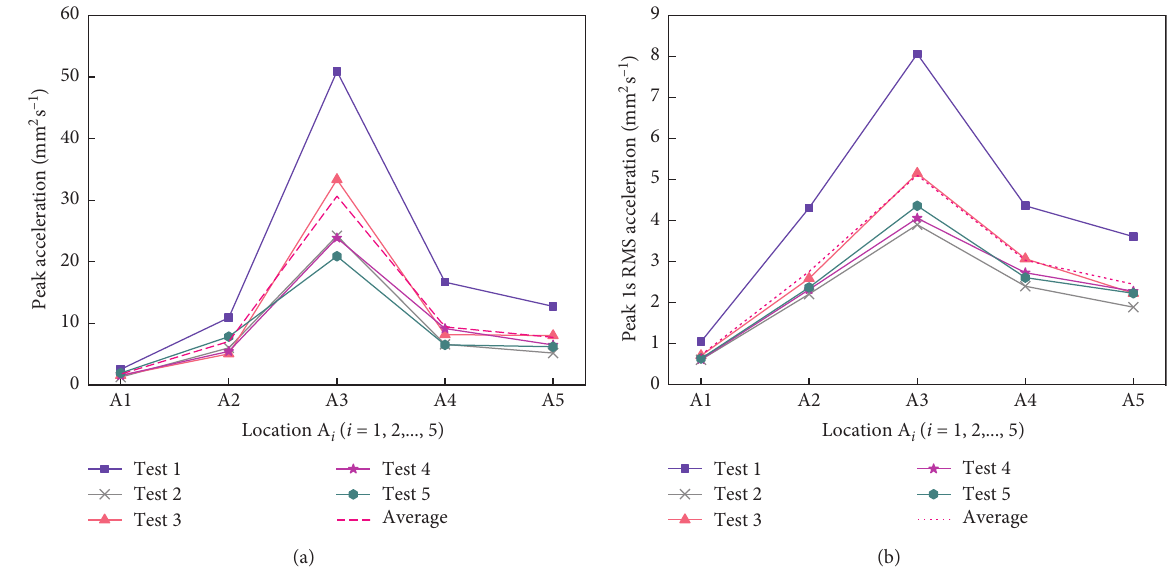
Figure 8: Acceleration distributions under single-person heel-dropping tests: (a) peak acceleration distributions; (b) peak 1s RMS ac- celeration